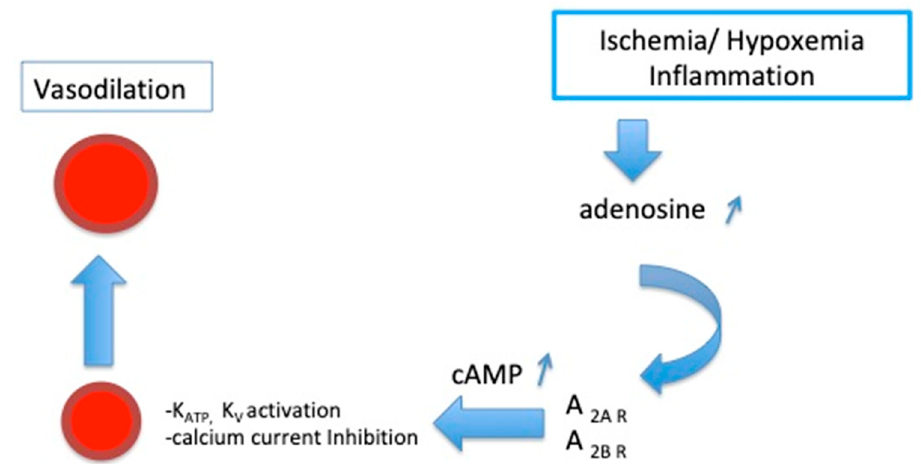
Figure 2. Schematic representation of the activation of A 2 receptor subtypes on coronary arteries. K ATP : ATP-sensitive potassium channels; K V : voltage-sensitive potassium channels.